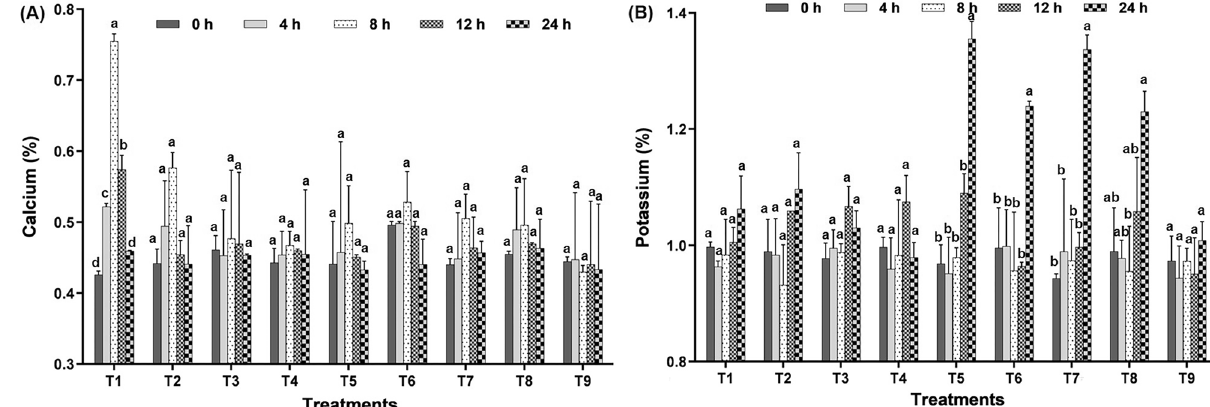
Figure 6. Effect of different treatments on ( A ) calcium and ( B ) potassium content in rice leaves (T 1 : Tricyclazole,